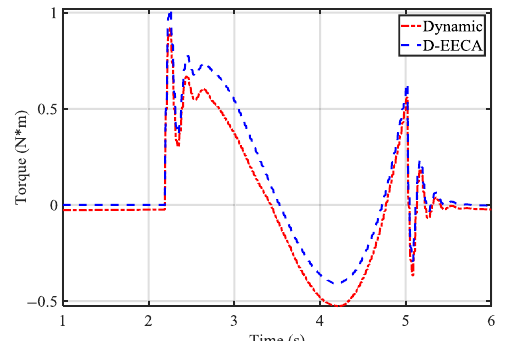
Figure 13 The steering angle of the front